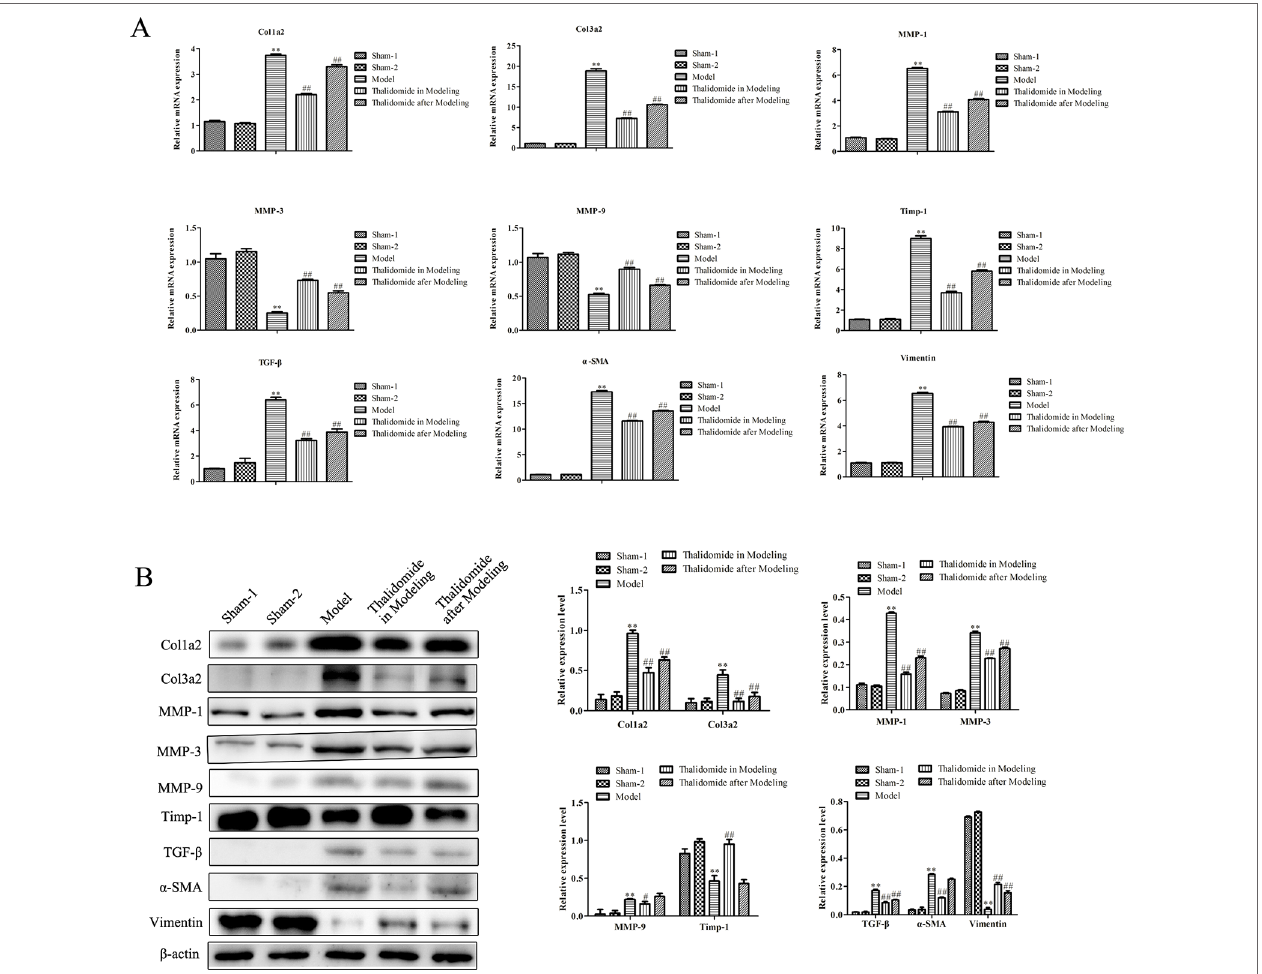
FIgURe 5 | Effects of thalidomide on mRNA and protein expression related to fibrosis in mice induced with TNBS. (A) QRT-PCR assay was performed to evaluate the expression levels of fibrosis-related mRNA in mice from different groups. (B) Western blot assay was performed to evaluate the expression levels of fibrosis- related proteins in mice from different groups. ** P < 0.01 compared with the sham-1 and sham-2 groups; # P < 0.05, ## P < 0.01 compared with the model group.